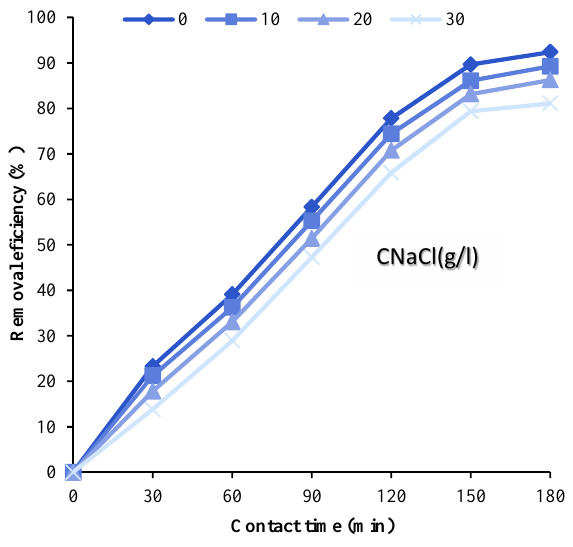
Figure 9. The effect of the initial concentration of phenol and contact time on the removal of phenol in the UV/ZnO process (pH = 3, and radiation intensity = 3950 µw/cm 2